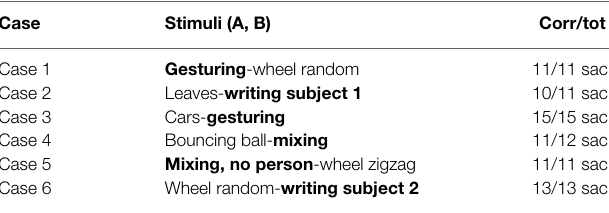
TABLE 4 | Number of correct saccades in integration experiment